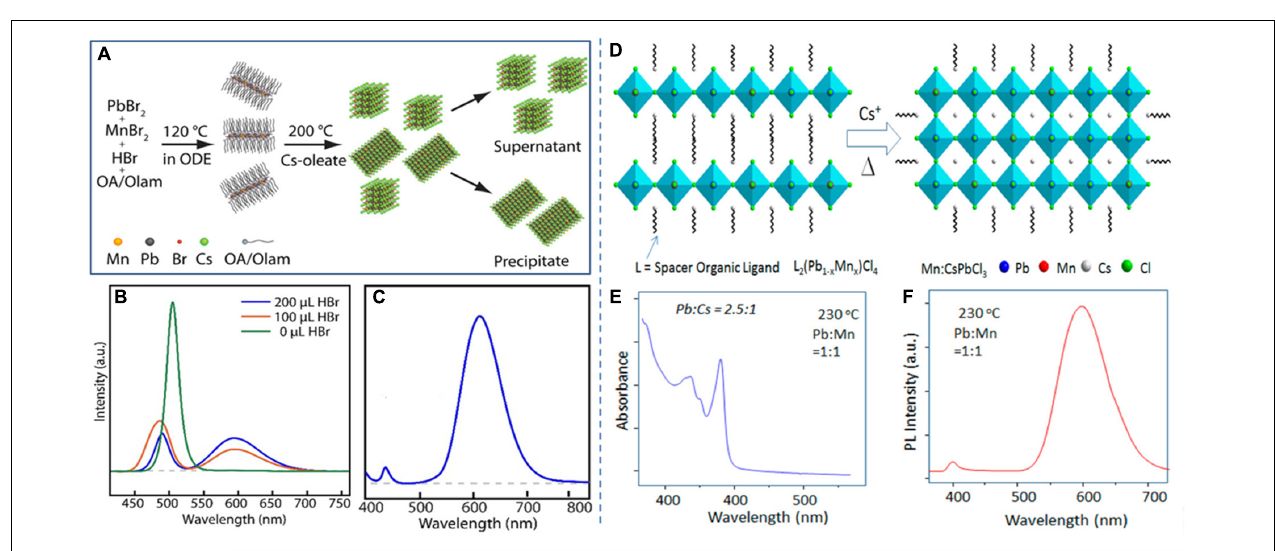
FIGURE 4 | (A) Schematic presentation of the stepwise formation of Mn-doped CsPbBr 3 nanocubes and nanoplatelets via the formation of Mn-doped L 2 PbBr 4 at 120 ◦ C. The PL spectra of (B) Mn-doped CsPbBr 3 nanocubes, at different amounts of HBr used during the reaction, and (C) Mn-doped CsPbBr 3 nanoplatelets. (D) Schematic presentation of the formation of layered perovskite to Mn-doped CsPbCl 3 nanoplatelets upon the thermal treatment of layered perovskites with Cs + precursor. (E) Absorbance spectrum and (F) corresponding PL spectrum of Mn-doped CsPbCl 3 nanoplatelets. (A–C) adapted from Parobek et al. (2018) and (D–F) adapted from Das Adhikari et al. (2018), with permission from the American Chemical